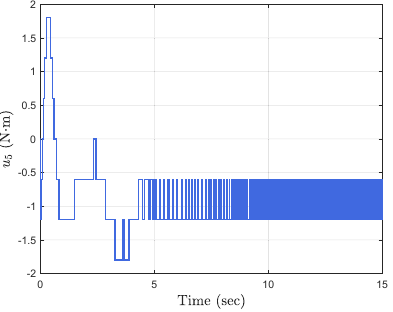
Figure 9. Event − triggered control input u 5 .